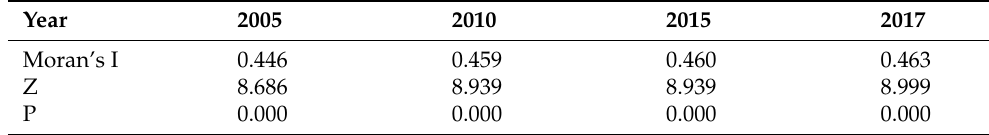
Table 4. The Global Moran’s I index from 2005 to